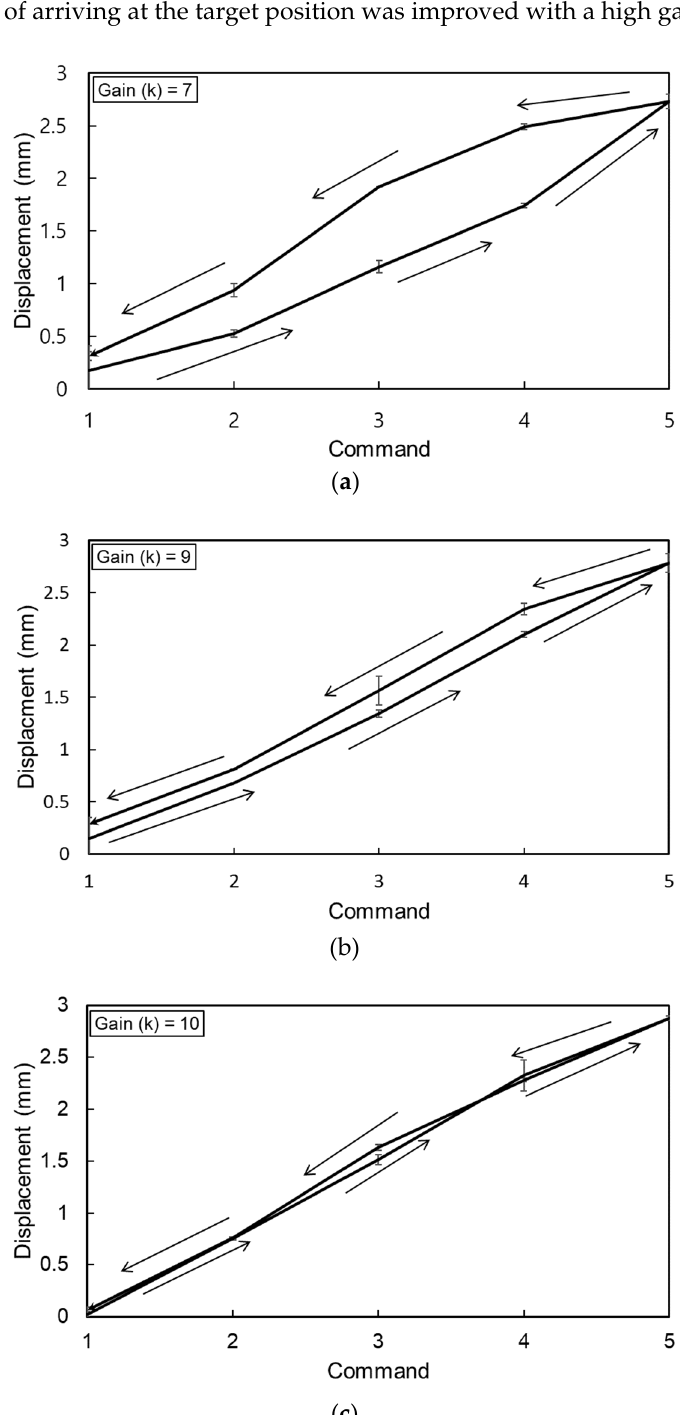
Figure 9. Hysteresis showing positional accuracy in lateral motion according to the gain (k) value while pressing the finger stage with a force of 2 N. ( a ) k = 7; ( b ) k = 9; ( c ) k = 10. The moving velocity of the finger stage is affected by the gain value. Figure 10 shows the time required to reach a target point 3 mm away for various gain values and vertical forces. When there was no vertical force, the maximum speed could be obtained when the